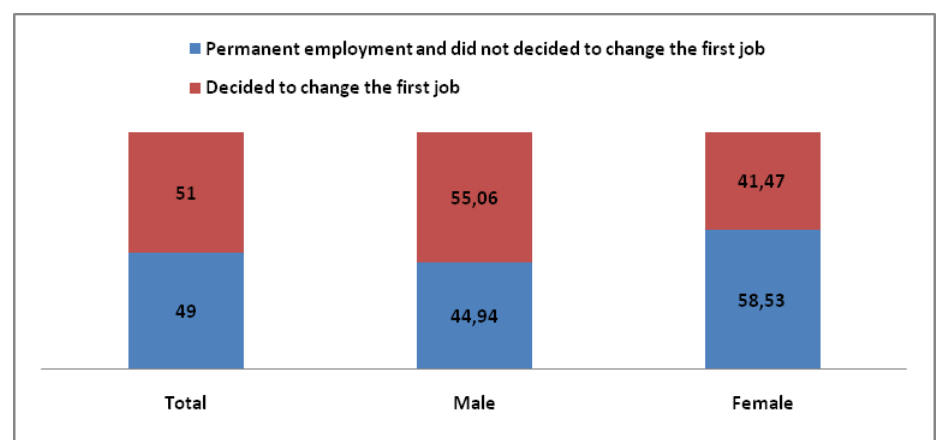
Figure 9: Percentage distribution of young people in the first transited job